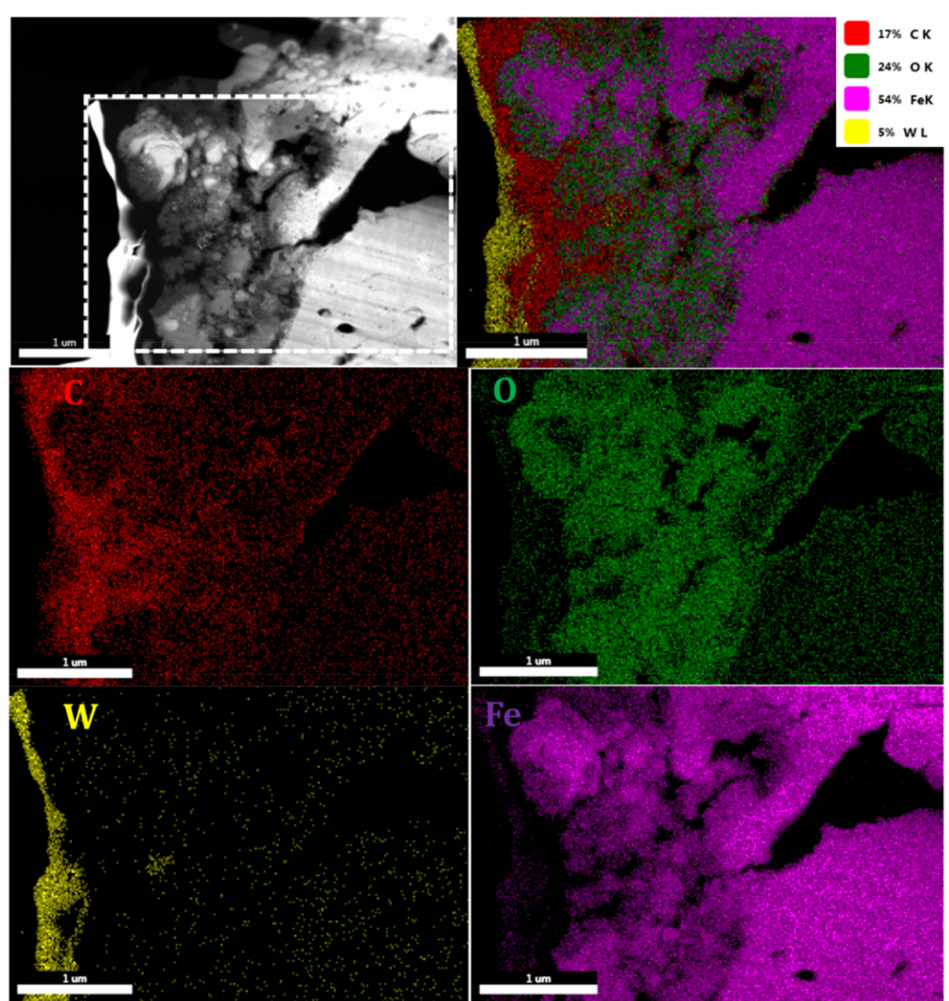
Figure 5. TEM-EDAX mapping of the laser-structured sample (F = 3.18 J/cm 2 ; CH = 1561 J/cm 2